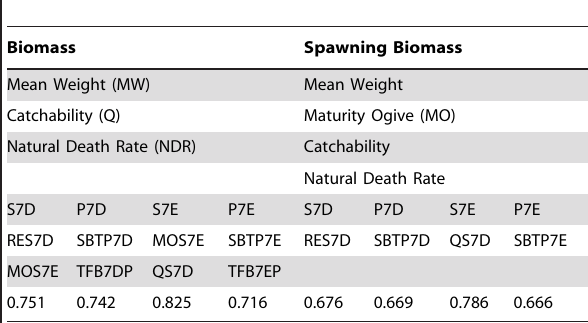
Figure 3. Results of the sensitivity analysis. Each row corresponds to one of the 81 input parameters tested and each column to an output variable. Output variables are biomass (B), Spawning Biomass (SSB), Fishing mortality (F) and Catch (Y). Results have to be studied in columns, black cells indicating important parameters for a given output. doi:10.1371/journal.pone.0077566.g003 Table 5. Input parameters most impacting output